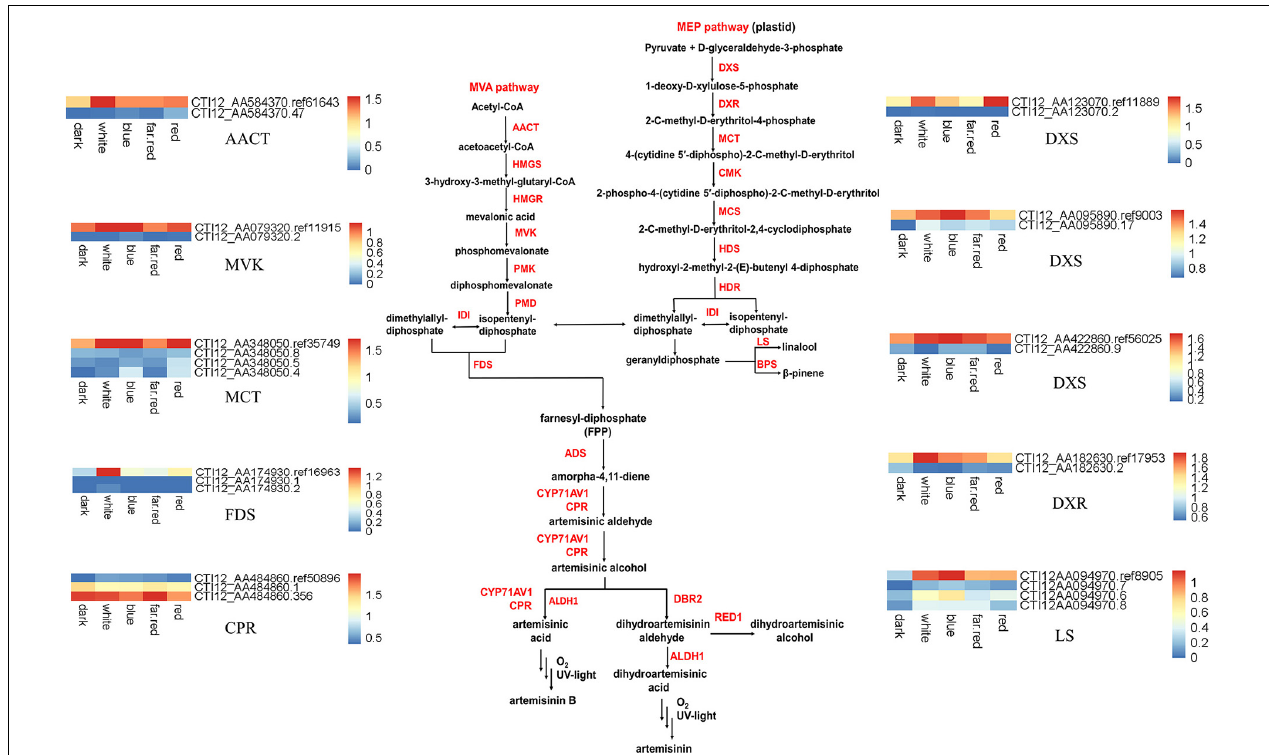
FIGURE 4 | Expression heatmap of the isoforms involved in artemisinin synthesis. The suffix “ref” indicates the reference isoform. For every gene, the reference isoform present in genome annotation is signed with the suffix “ref” or “rna” plus a series of number, while other isoforms newly identified are signed with pure number in its suffix. For example, CTI12_AA584370.ref61643 is the reference isoform of AACT while CTI12_AA584370.47 is a newly identified AS isoform. AACT, Acetyl-CoA C-acetyltransferase; HMGS, 3-Hydroxy-3-methylglutaryl-CoA synthase; HMGR, 3-Hydroxy-3-methylglutaryl-CoA reductase; MK, MVA kinase; PMK, Phospho-MVA kinase; MDC, Diphospho-MVA decarboxylase; DXS, 1-Deoxy- D -xylulose-5-phosphate synthase; DXR, 1-Deoxy- D -xylulose 5-phosphate reductoisomerase; MCT, 2-C-methyl- D -erythritol 4-phosphate cytidylyltransferase; CMK, 4-(Cytidine-5-diphospho)-2-C-methyl- D -erythritol kinase; MDS, 2-C-methyl- D -erythritol-2,4-cyclodiphosphate synthase; HDS, 4-Hydroxy-3-methylbut-2-enyl-diphosphate synthase; HDR, 4-Hydroxy-3-methylbut-2-enyl diphosphate reductase; GGPPS (E, E, E)-geranylgeranyl diphosphate